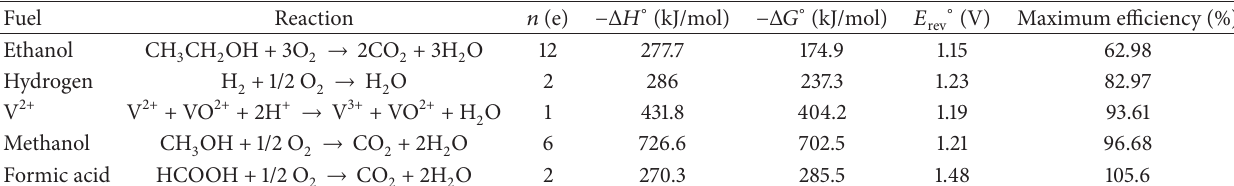
Table 1: Theoretical open-circuit potential and maximum efficiency of various fuels.